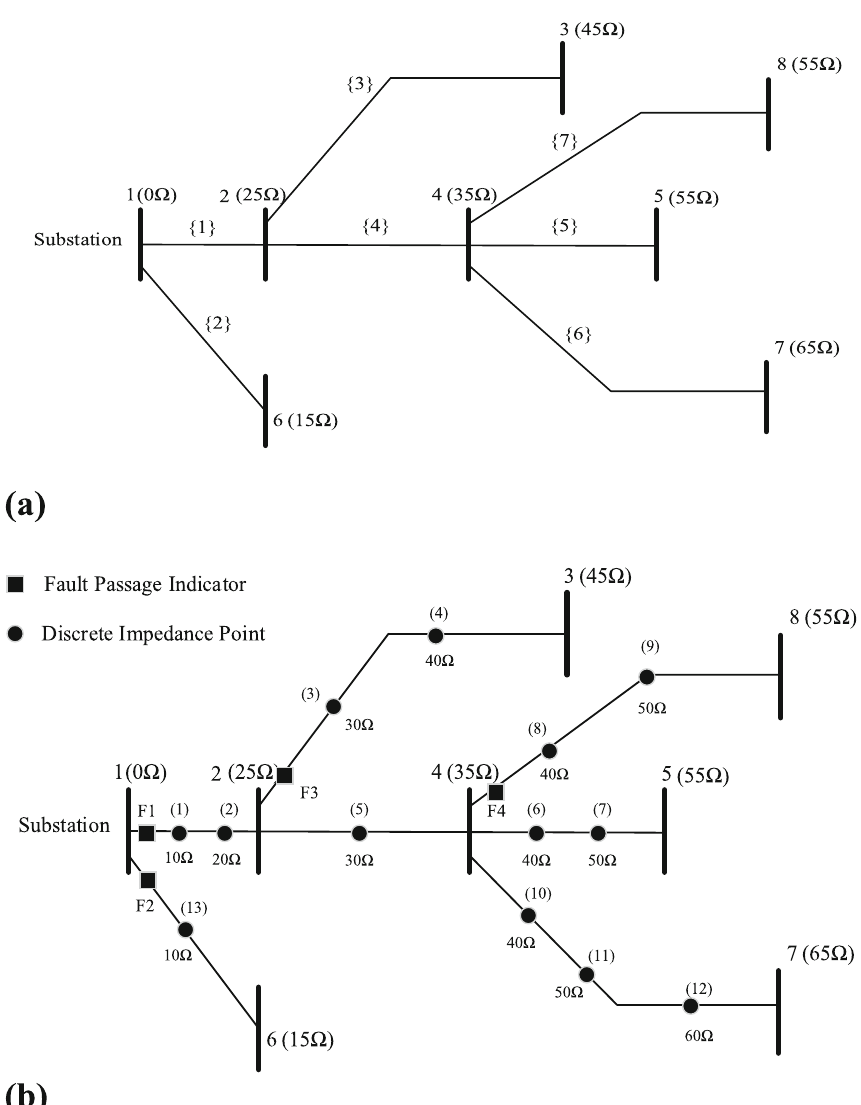
Fig. 3 a Eight bus radial feeder. b FPIs placed in eight bus feeder with an impedance step size of 10